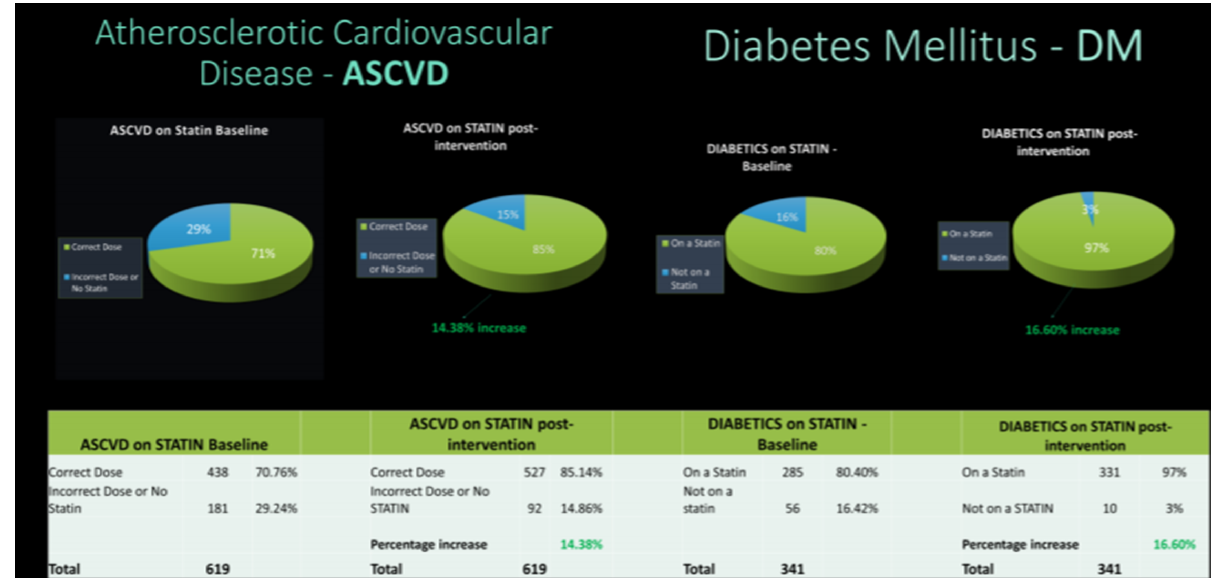
Figure 3. Comparison of appropriate statin use in both groups at baseline and the end of the study.